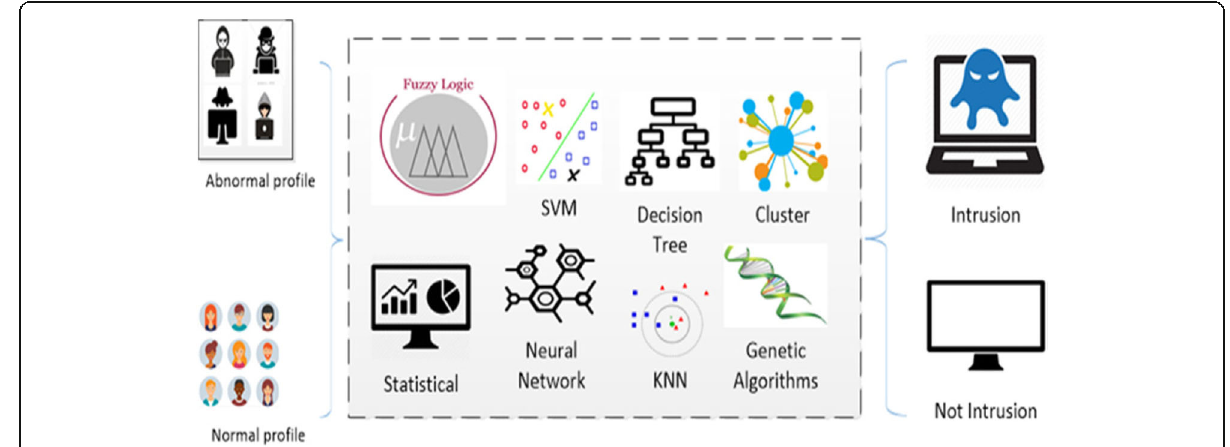
Fig. 3 Conceptual working of AIDS approaches based on machine learning